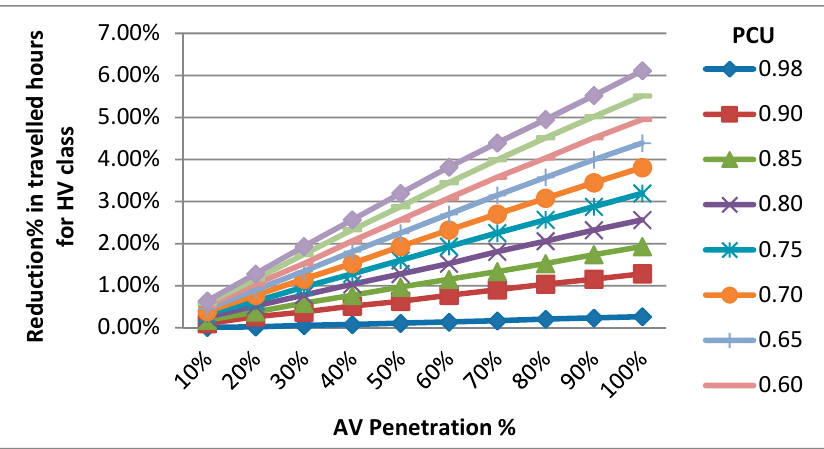
Figure 4. Reduction percent in traveled hours for heavy vehicle class.